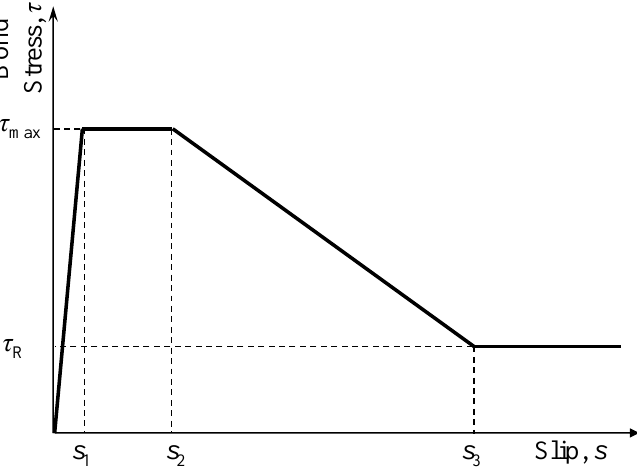
Figure 5. Idealized bond stress-slip relationship used to model the behavior of epoxy mortar.